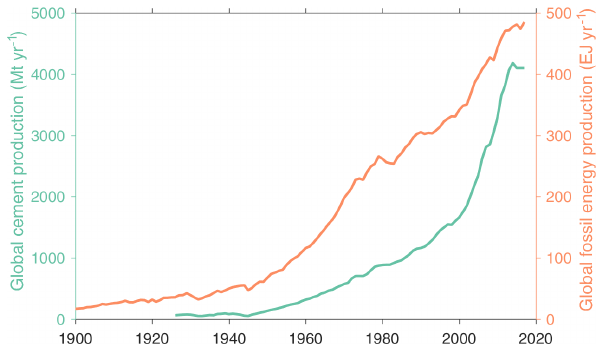
Figure 1. Global cement and fossil energy production to 2017 (USGS, 2014, 2018; Mohr et al., 2015; BP, 2018).